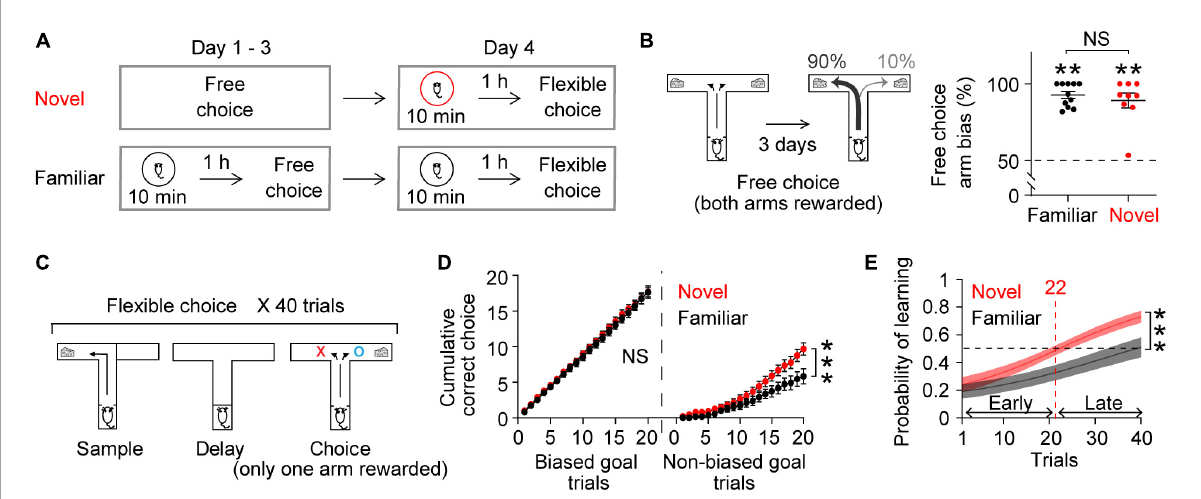
FIGURE1 Novel experience enhances flexible learning. (A) Experimental design. (B) Mice established an arm bias after 3 days of free choice sessions, before exploring a novel ( n = 9) or a familiar ( n = 11) arena on day 4 (Wilcoxon signed-rank test, Novel, P = 0.004; Familiar, P = 0.001; Novel vs. Familiar, Mann Whitney test, P = 0.8). (C) Flexible choice task. The mice had to flexibly choose a goal side opposite to the randomly given sample goal. (D) Both groups of mice performed similarly when the choice goal matched their biased arm side [Left, trial × group, F ( 19 , 342 ) = 0.3, P = 0.9]. However, the novel group displayed an improved performance at later trials when the choice goal mismatched their biased arm side [Right, trial × group: F ( 19 , 342 ) = 4.4, P < 0.0001]. (E) Logistic regression model learning curve. Mice exposed to novelty progressively performed better in flexible choice training than those exposed to the familiar arena [trial × group: F ( 39 , 702 ) = 2.7, P < 0.0001]. The average inflection point (learning trial) was 22 (Novel), and 44 (Familiar) (Mann–Whitney test, P = 0.02). Insets, learning trial of each mouse. The learning trial of two mice in the Familiar group was not defined because the overall slope of their learning curve was negative, indicating that learning had not occurred. Two-way RM ANOVA test for (D,E) . NS. not significant, ** P < 0.005, *** P < 0.0005. Data are represented as mean ± SEM. [B (left), C] Adopted from Park et al.